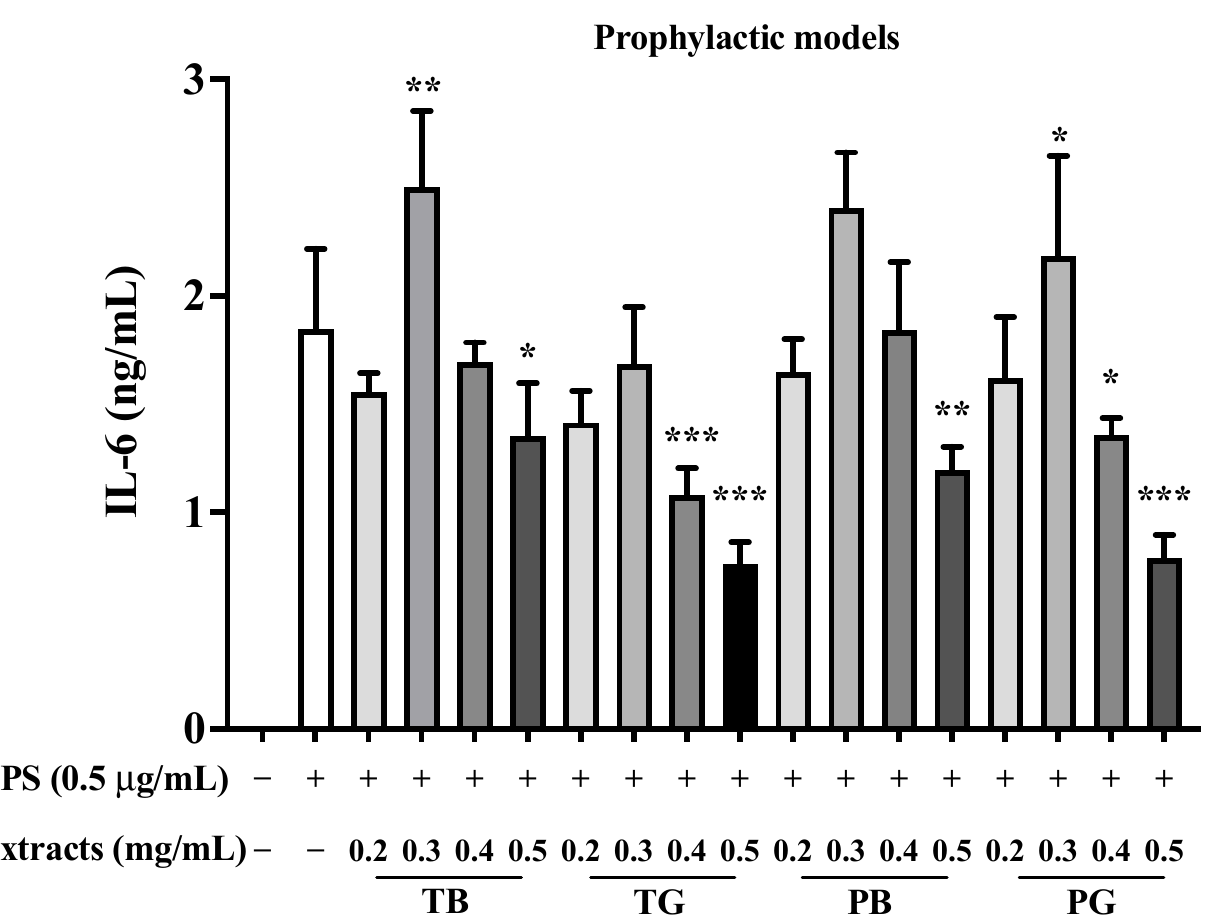
Figure 10. Effect of various extracts from tea on IL-6 secretion of LPS-stimulated macrophages in the prophylactic model. LPS (0.5 µ g/mL) was added to all groups until assay, except the control group. In the LPS-stimulated macrophages, the cells were incubated in the medium without/with various concentrations of tea samples. In our prophylactic model, the pretreatment of four tea extracts was performed for 8 h. Then LPS (0.5 μ g/mL) was added and co-incubated for the remaining 16 h to explore the prophylaxis of the four teas. The data were presented as mean ± SE of three experiments. * p < 0.05; ** p < 0.01; *** p < 0.001. IL-6: Interleukin-6; LPS: lipopolysaccharide; T: Taiwan Tea Experiment Station No. 12; P: purple shoot tea; G: green tea and B: black tea.